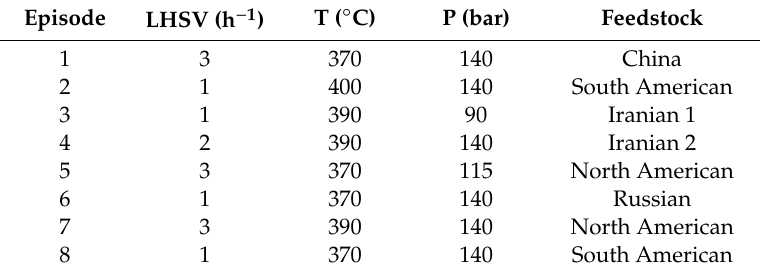
Table 1. Operating conditions of eight selected episodes.